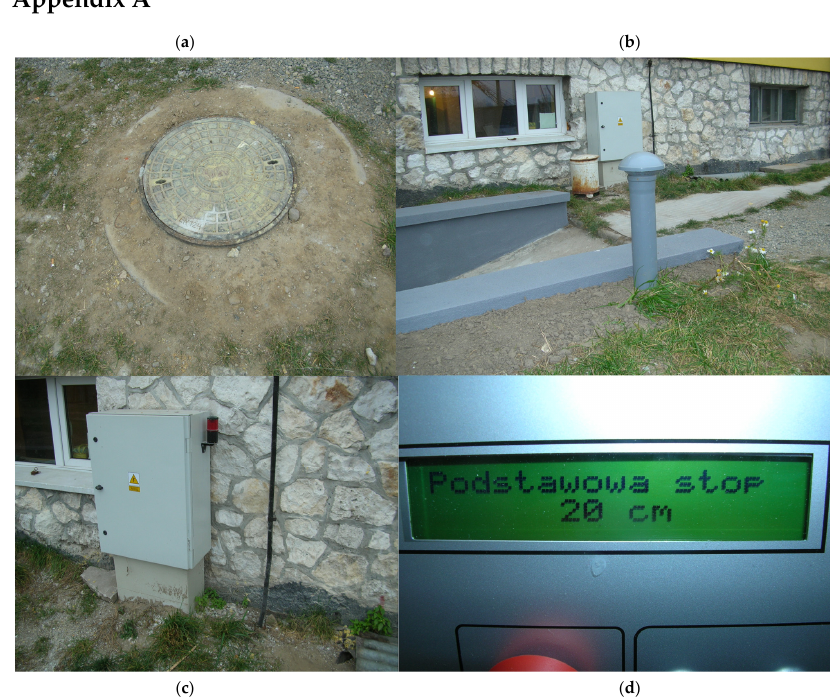
Figure A1. Pictures of field work while conducting measurements in the backyard of a residential house. ( a ) Pass-through manhole of the sewage pumping station; ( b ) View of the selected pumping station including the stack and control cabinet; ( c ) Control cabinet including optical indicator; ( d ) Controller—readout of pump shutdown level.